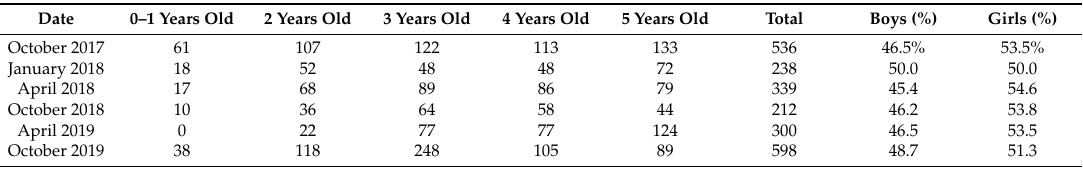
Table 1. Number of examined